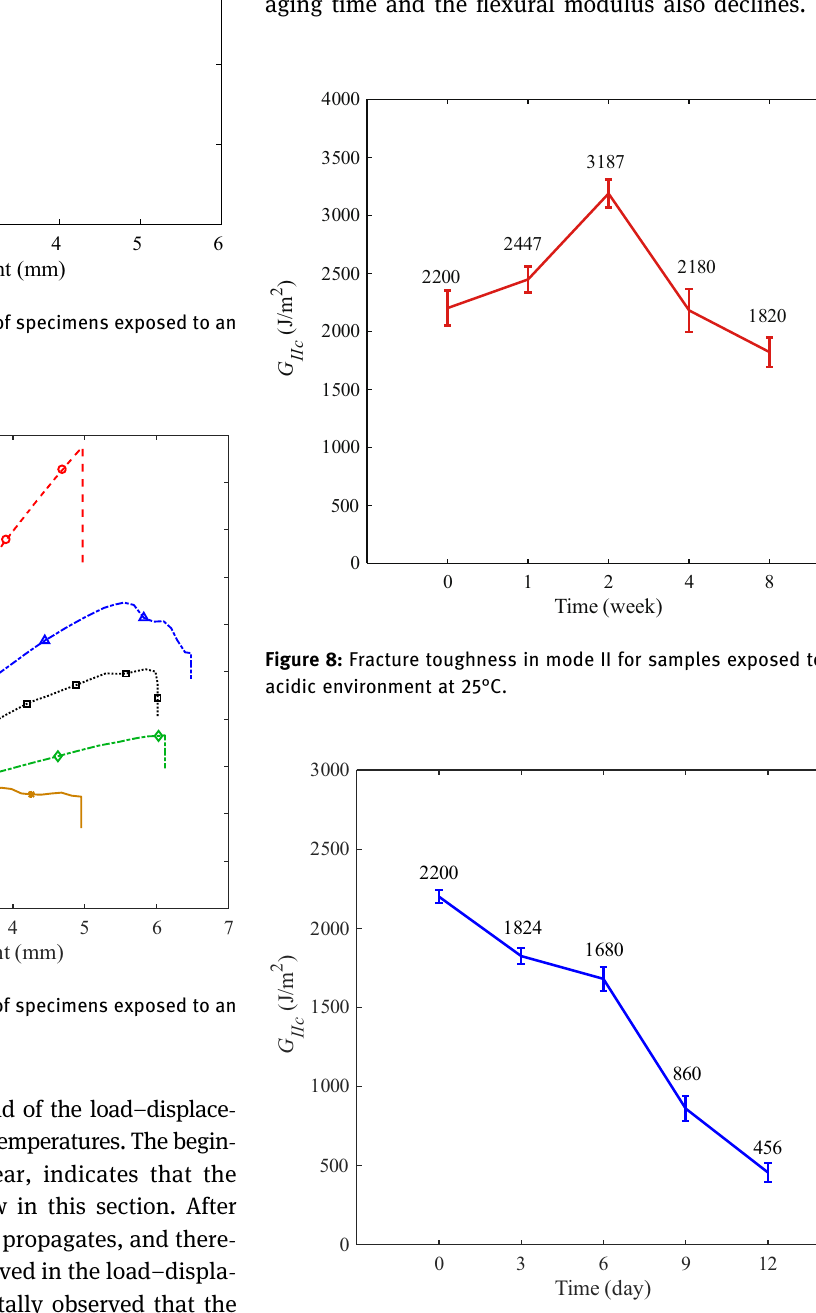
Figure 9: Mode II fracture toughness of samples exposed to an acidic environment at